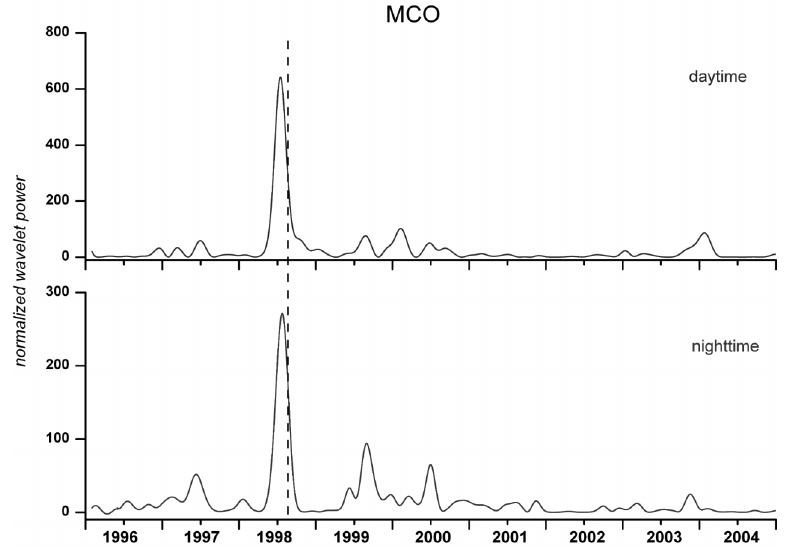
Fig. 3. Normalized wavelet power trend from February 1996 to December 2004 of the MCO electric field strength at daytime and at nighttime for the period 50 days that corresponds to the maximum power. The dashed vertical line indicates the time occurrence of the Reatini mountains main shock ( M =